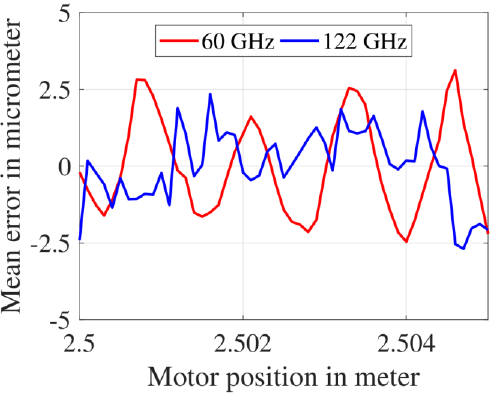
. Figure 11. Standard deviation of the final distance measurement errors. 4. Discussion In this work, high-accuracy, short-range distance measurements were performed using a 60 GHz and 122 GHz FMCW radar. An accuracy of a few micrometers was achieved in both cases by using a combined frequency- and phase-estimation method. In addition, the CRLB for phase estimation was experimentally validated. The following conclusions are drawn on the basis of the measurement results. 